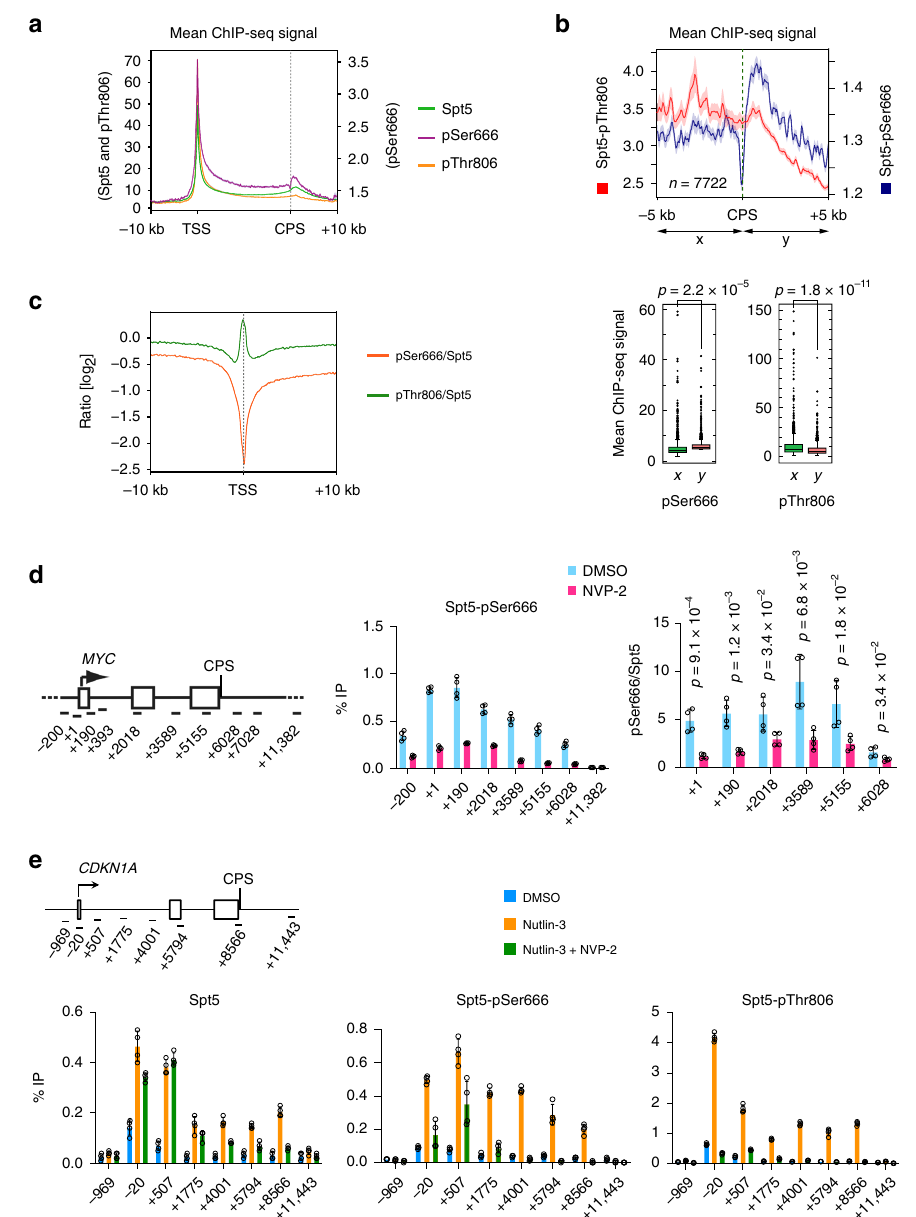
Fig. 4 Chromatin distribution of Spt5-pSer666 is distinct from that of pThr806. a Metagene analyses ( n = 20,130 genes) of ChIP-seq data for total Spt5, Spt5-pThr806, and Spt5-pSer666 ( n = 2 biological replicates). b Genes separated from their neighbors at both ends by >10 kilobases ( n = 7772) show signi fi cant accumulation of pSer666 but not pThr806 downstream of the CPS (top, metagene plots; bottom, box plots). c Metagene analysis of pSer666: Spt5 and pThr806:Spt5 ratios centered over TSS ( n = 20,130 genes). d ChIP-qPCR analysis of Spt5-Ser666 phosphorylation on MYC gene in HCT116 cells treated with NVP-2 (250 nM) or mock treated (DMSO) for 1 h. e Schematic of the CDKN1A gene, indicating positions of primer pairs used in ChIP-qPCR analysis (top). ChIP-qPCR analysis of total Spt5, Spt5-pSer666, and Spt5-pThr806 in HCT116 cells mock treated (DMSO) or treated with 5 μ M nutlin-3 alone or together with 250 nM NVP-2 for 2 h. Error bars indicate ±s.d. from mean of four independent biological replicates ( n = 4) ( d and e ). Individual data points from biological replicates are shown; indicated p values were calculated using two-sided Student ’ s t test ( b , d , and e ). Source data are provided as a Source data fi